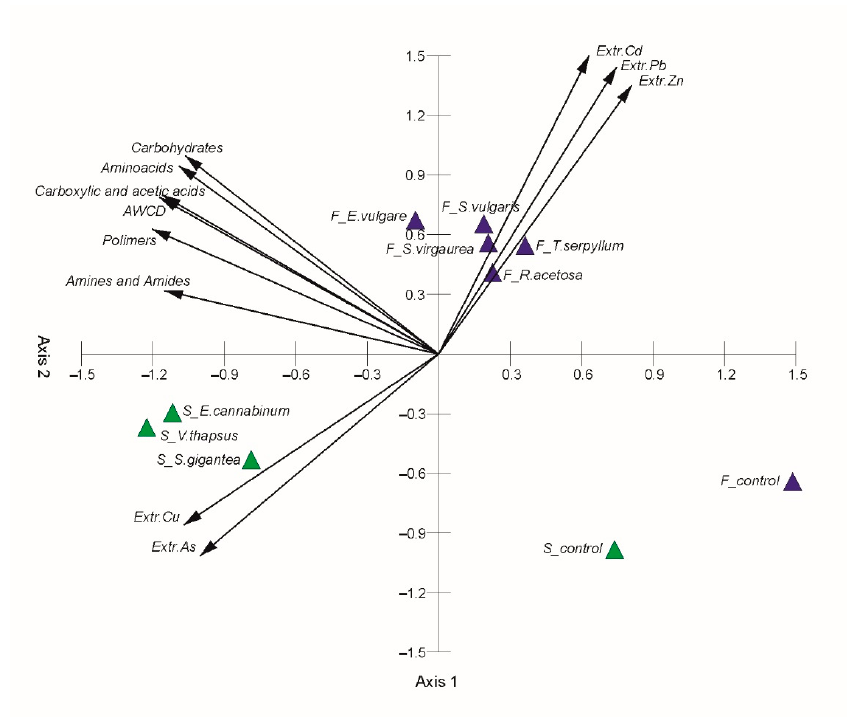
Figure 3. Principal component analysis (PCA) of metabolic activity parameters (based on EcoPlate) and extractable PTTE in FW and SW soils. and extractable PTTE in FW and SW